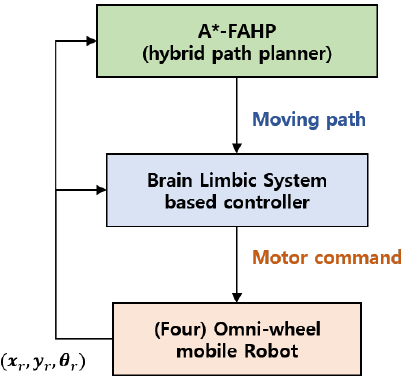
Figure 1. The schematic diagram and coordinate system of the parking